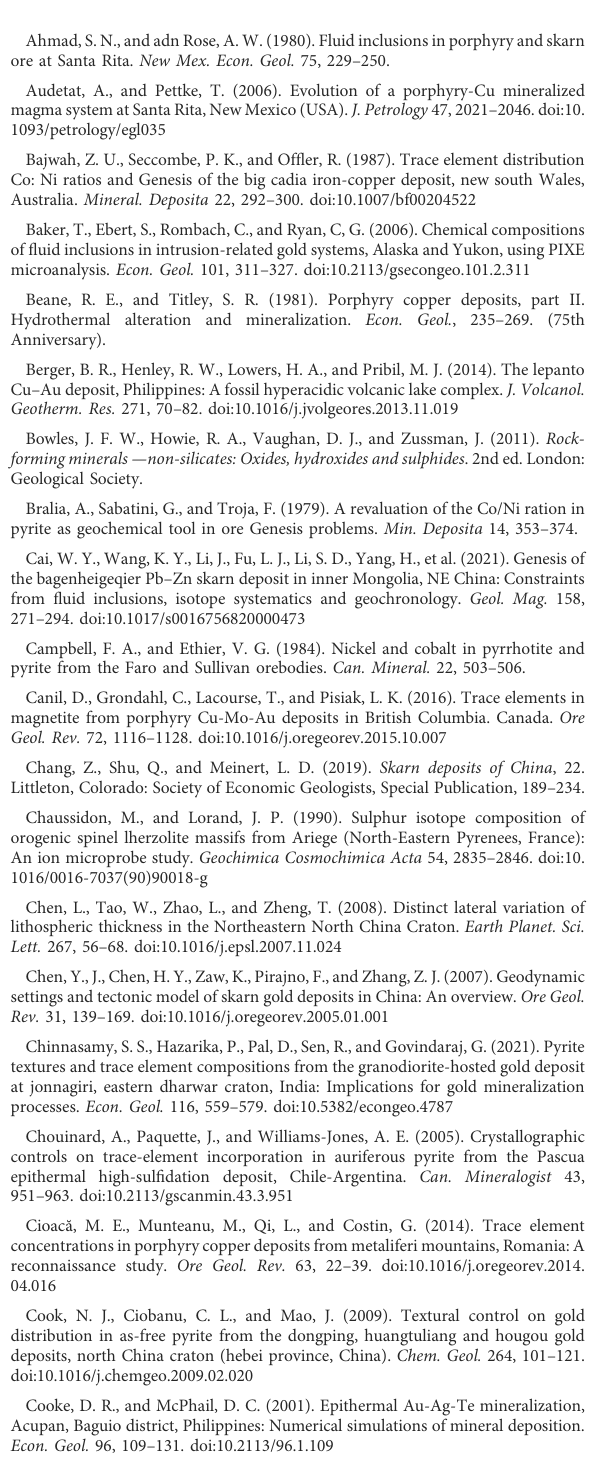
Sulfur isotope composition of sul fi des from Tongjing Au-Cu deposit. SUPPLEMENTARY TABLE S4 Lead isotope composition of sul fi des from Tongjing Au-Cu